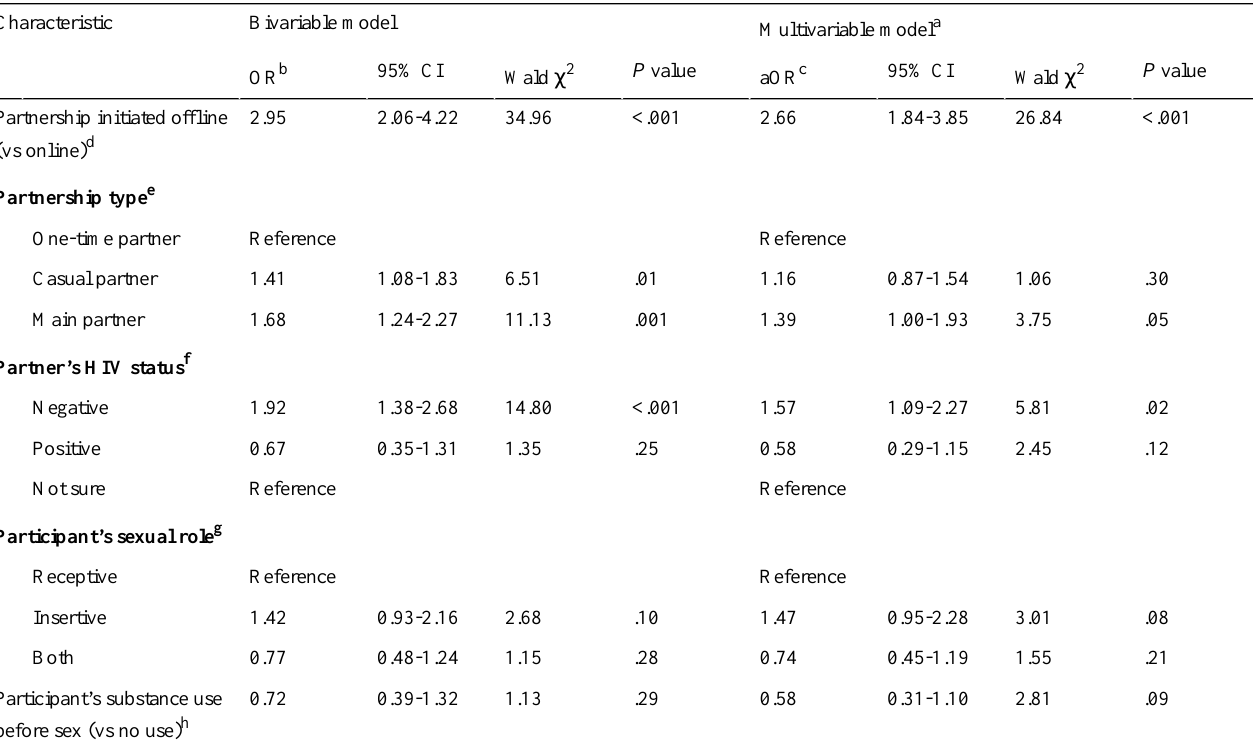
Table 3. Interval-level characteristics and unprotected anal sex among 1311 adult Blued app users in 4 provinces in China.